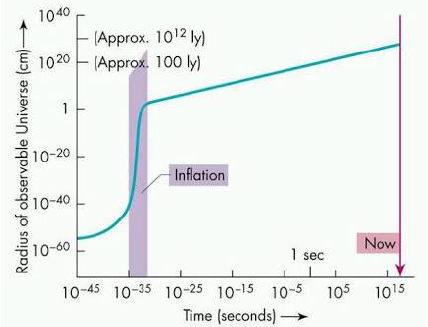
Figure 16. History of the universe beginning with big bang and expanding with inflation.